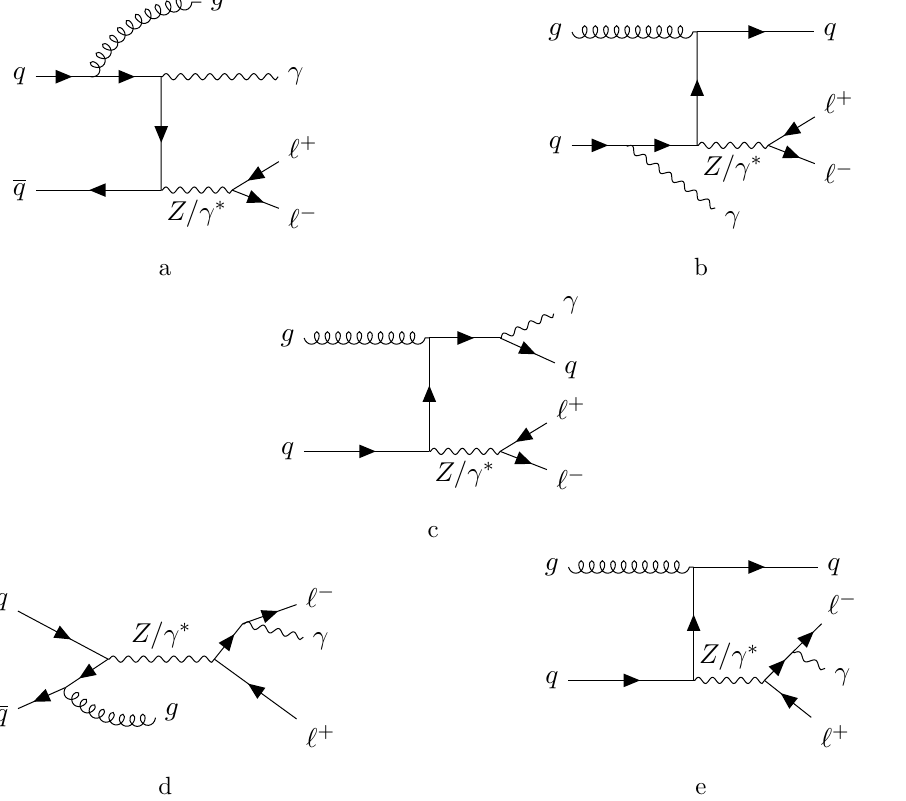
Figure 2. Sample LO diagrams for ‘ + ‘ − γ +jet production including q -type diagrams (a–c) and ‘ -type diagrams